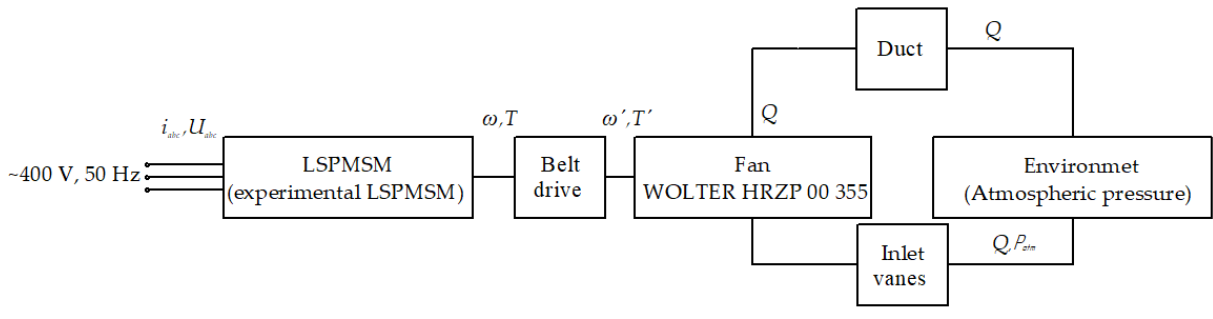
Figure 2. The block diagram of the centrifugal fan with the LSPMSM drive.